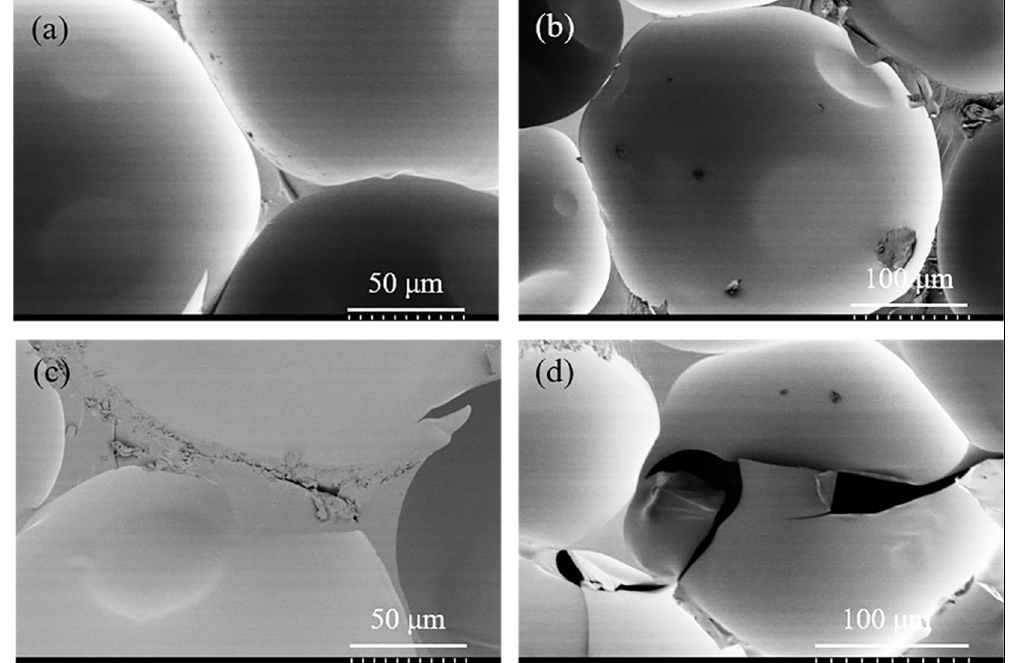
Figure 3. Microstructure (SEM) of the RPUF samples. Where, ( a , b ) is the sample without vibration, ( c , d ) is the sample after vibration.